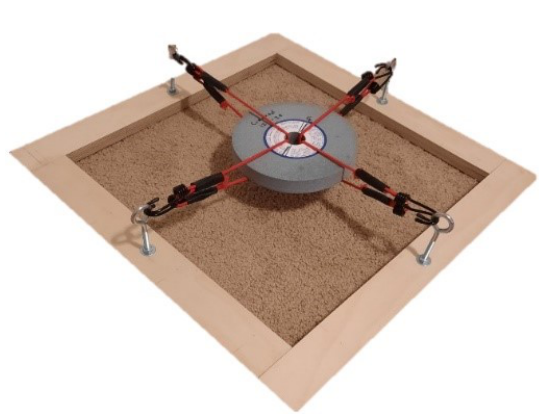
Figure 4. Test fixture to suspend the grinding